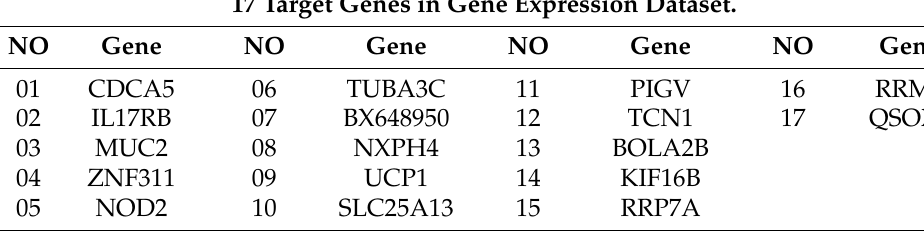
Table 3. Target genes in three datasets. 17 Target Genes in Gene Expression